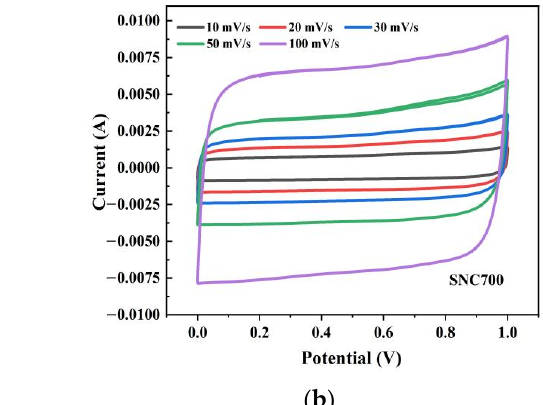
Figure 12. Electrochemical impedance spectra of SNC and NC at different carbonization tempera- tures (The equivalent circuit diagram of this electrode is shown in the upper left corner of the figure).